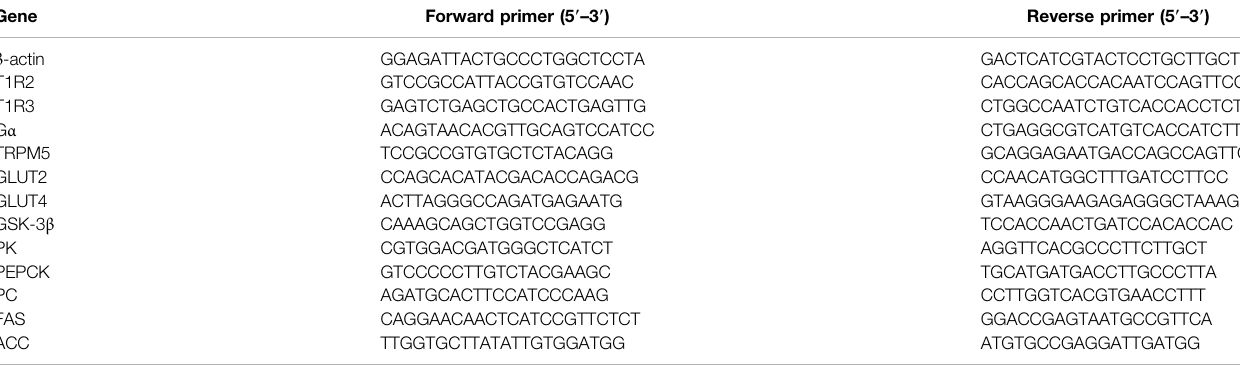
TABLE 1 | The product sizes and sequences of primers used in